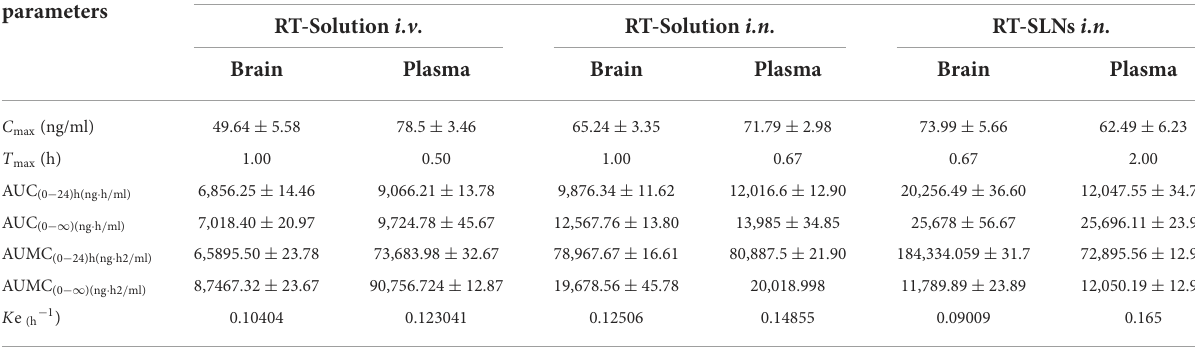
TABLE 3 Results of various pharmacokinetics parameters of RT-SLN (i.n.) and RT solution after i.n. and i.v. administration ( n = 3). PK